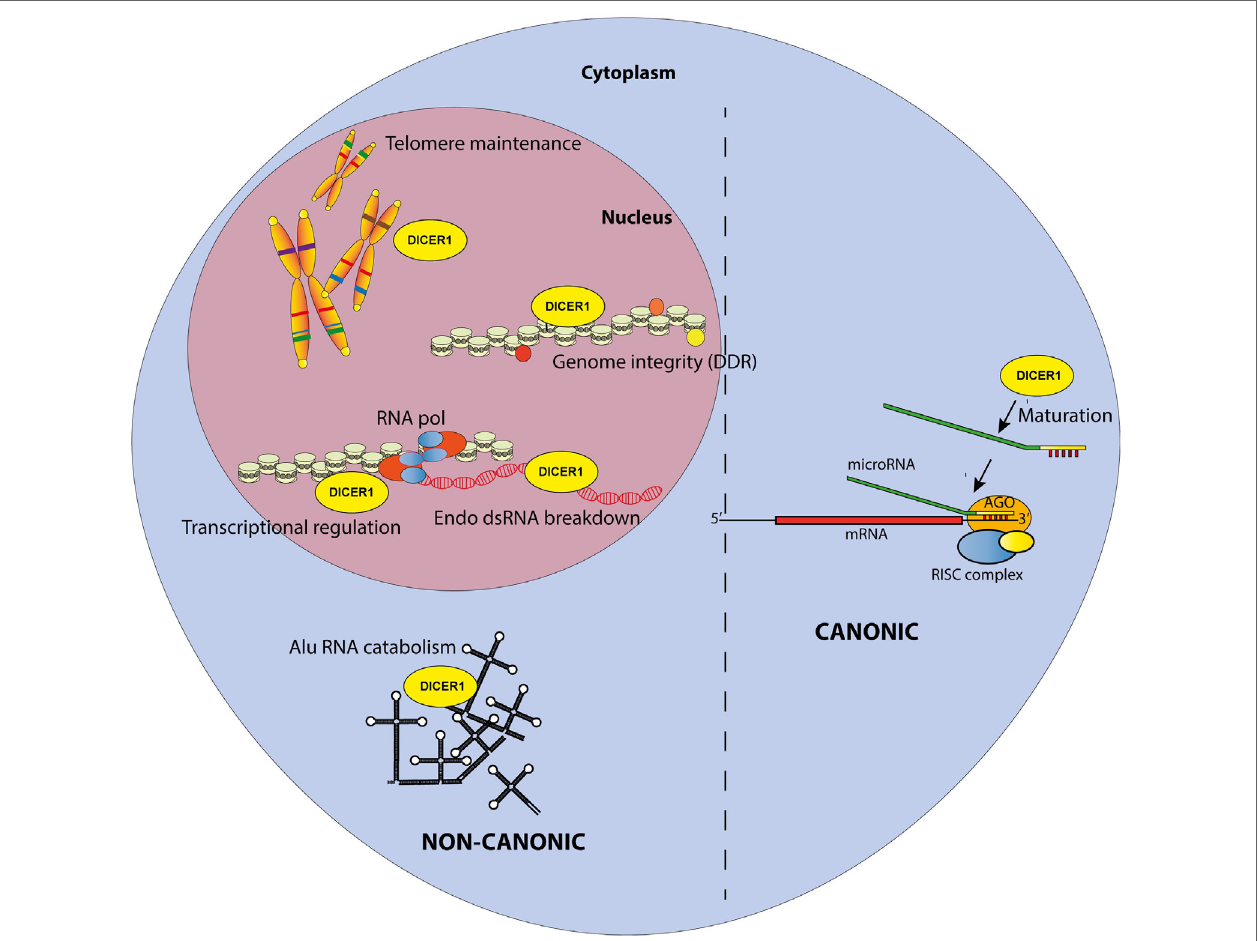
FiGuRe 1 | Canonical and non-canonical functions of DICER1 in the nucleus and the cytosol. The canonical function of DICER1 leads to microRNA maturation in the cytoplasm. Others functions are considered